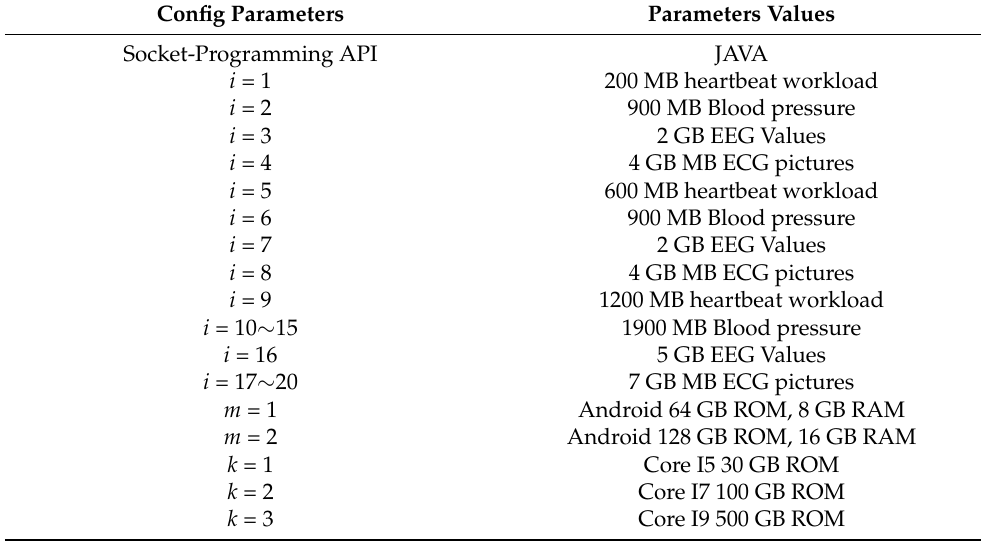
Table 3. Simulation Parameters of Blockchain Socket RMI for Fine-Grained Healthcare Application.